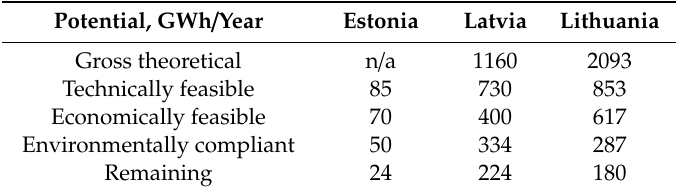
Table 3. The small hydropower electricity generation potential in the Baltic States. Potential, GWh /